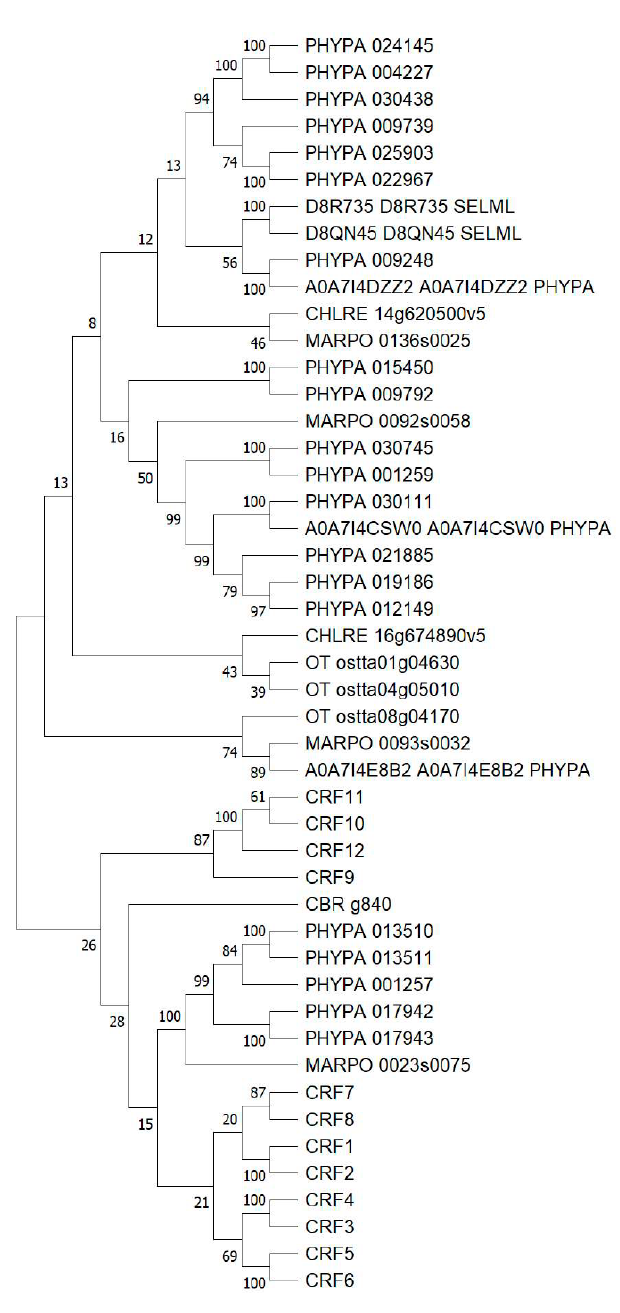
Figure 1. Phylogenetic analysis of CRFs in early diverging land plants and algae. CRF9 of Arabidopsis was used as a query in a HMMR search to find homologs in different plant species ( Ostreococcucs taurii OT, Chlamydomonas rheinhardtii CHLRE, Klebsormodium nitans , Chara braunii CBR, Mesotigma viride , Marchantia polymorpha MARPO, Physcomitrium patens PHYPA, Selaginella moelendorfii SELML). After a quality check, the resulting positives were aligned using the MAFFT program, and a Maximum Likelihood tree was calculated based on the resulting alignment. The quality of the tree was evaluated using 200 bootstrap repetitions.